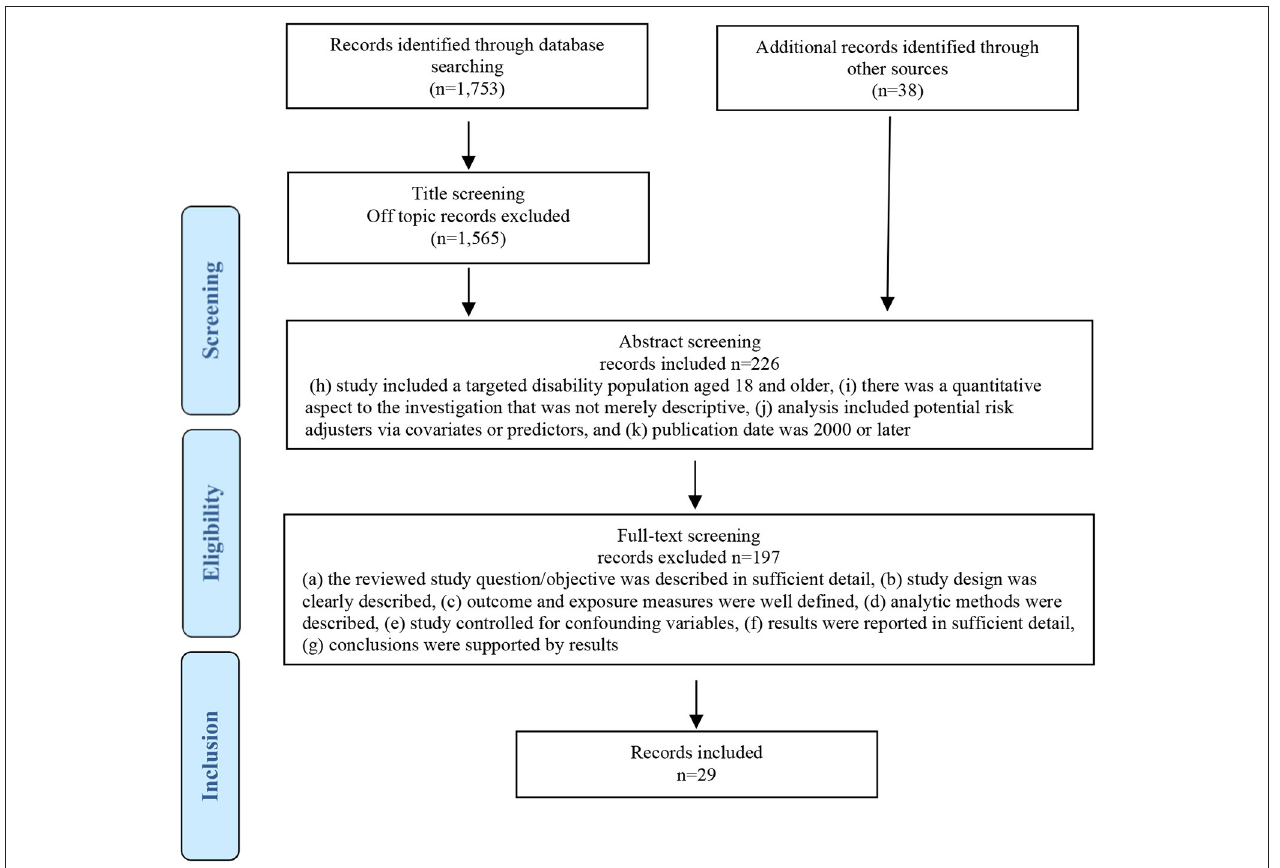
FIGURE 2 | Flow diagram of literature search and selection process.